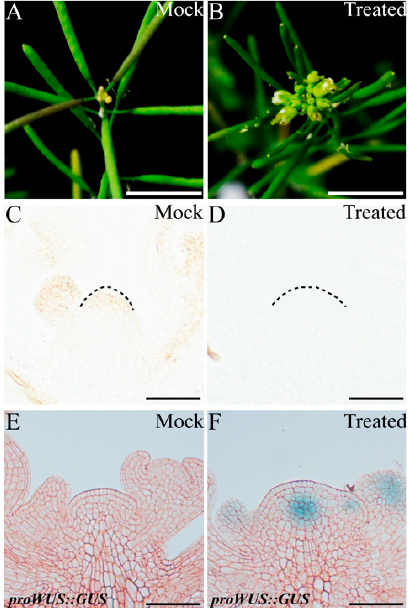
Int. J. Mol. Sci. 2022 , 23 , x FOR PEER REVIEW 10 of 17 Figure 9. The phenotype of primary shoot inflorescence ( A , B ), H 2 O 2 accumulation ( C , D ), and WUS expression profile ( E , F ) of the control group (mock) and 5 mM KI-treated group. Black dotted lines indicate the shape of the IM. Scale bars: 1 cm in ( A , B ), 35 μ m in ( C – F ). apex development and that the clv3-2 mutant might have a higher ability of H 2 O 2 clear- ance than WT.